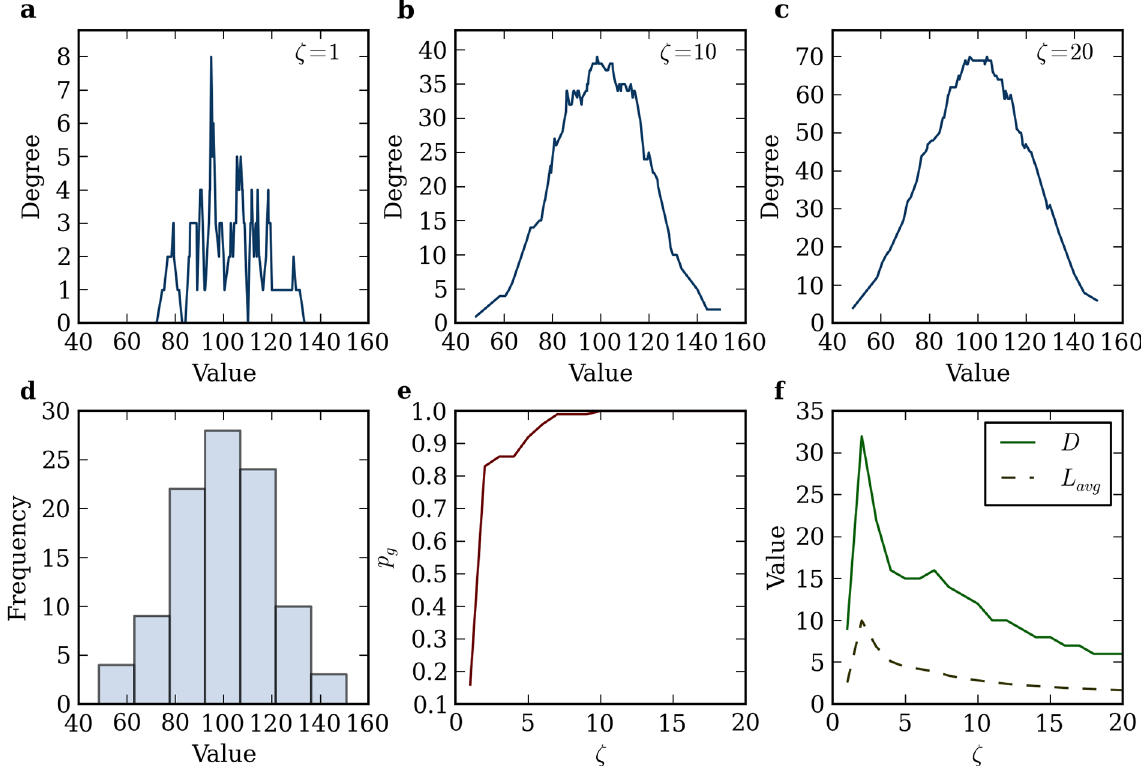
Fig 1. Impact of ζ on NB Methodology and Network Properties. (A)-(C) Scatter plots of values and their degrees (i.e., number of connections) for ζ = 1, 10, 20 respectively. (D) Histogram of distribution where the bin size of 14.70 was calculated using Scott ’ s rule. We can see that the right shape is obtained but the bins are large. (E) Evolution of p g with ζ . (F) Evolution of the D and L avg with ζ . In practice, we choose ζ as a low percentage of the median of the distribution, say 1%, and we then increase it gradually until the value of p g becomes constant over several increases of ζ (this number of increases depends on the magnitude of increase between every ζ ); here, we find the network becomes stable for ζ =